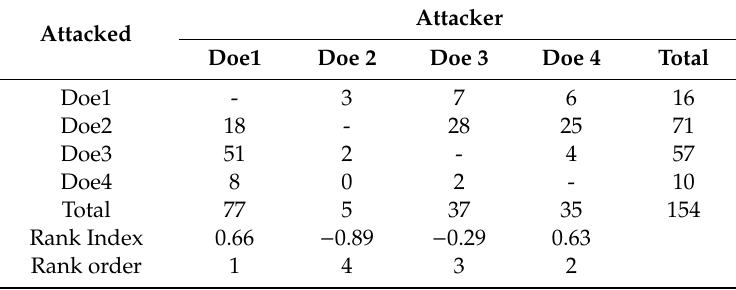
Table 1. Dominance rank order based on the number of fights among the does (HOM1).